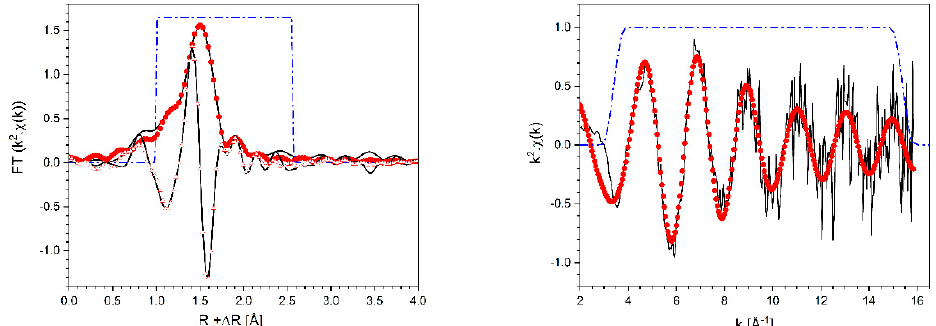
Figure 5. ( left ) Experimental and theoretical k 2 -weighted Np L3-EXAFS spectra, and ( right ) Fourier transforms (modulus and imaginary parts) for Np(VII) aqueous species in a 2.0 M NaOH + 3.0 M NaCl solution.